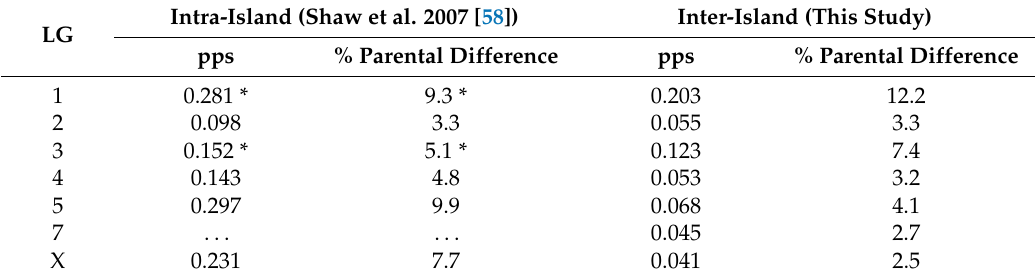
Table 4. Comparison of the QTL effects for intra-island versus inter-island divergence. The QTL effects (in pulses per second and as a percentage of the parental difference) are shown for the Shaw et al. (2007) [58] study (the intra-island comparison, results from Table 2b in that study) and for the results of the present study (the inter-island